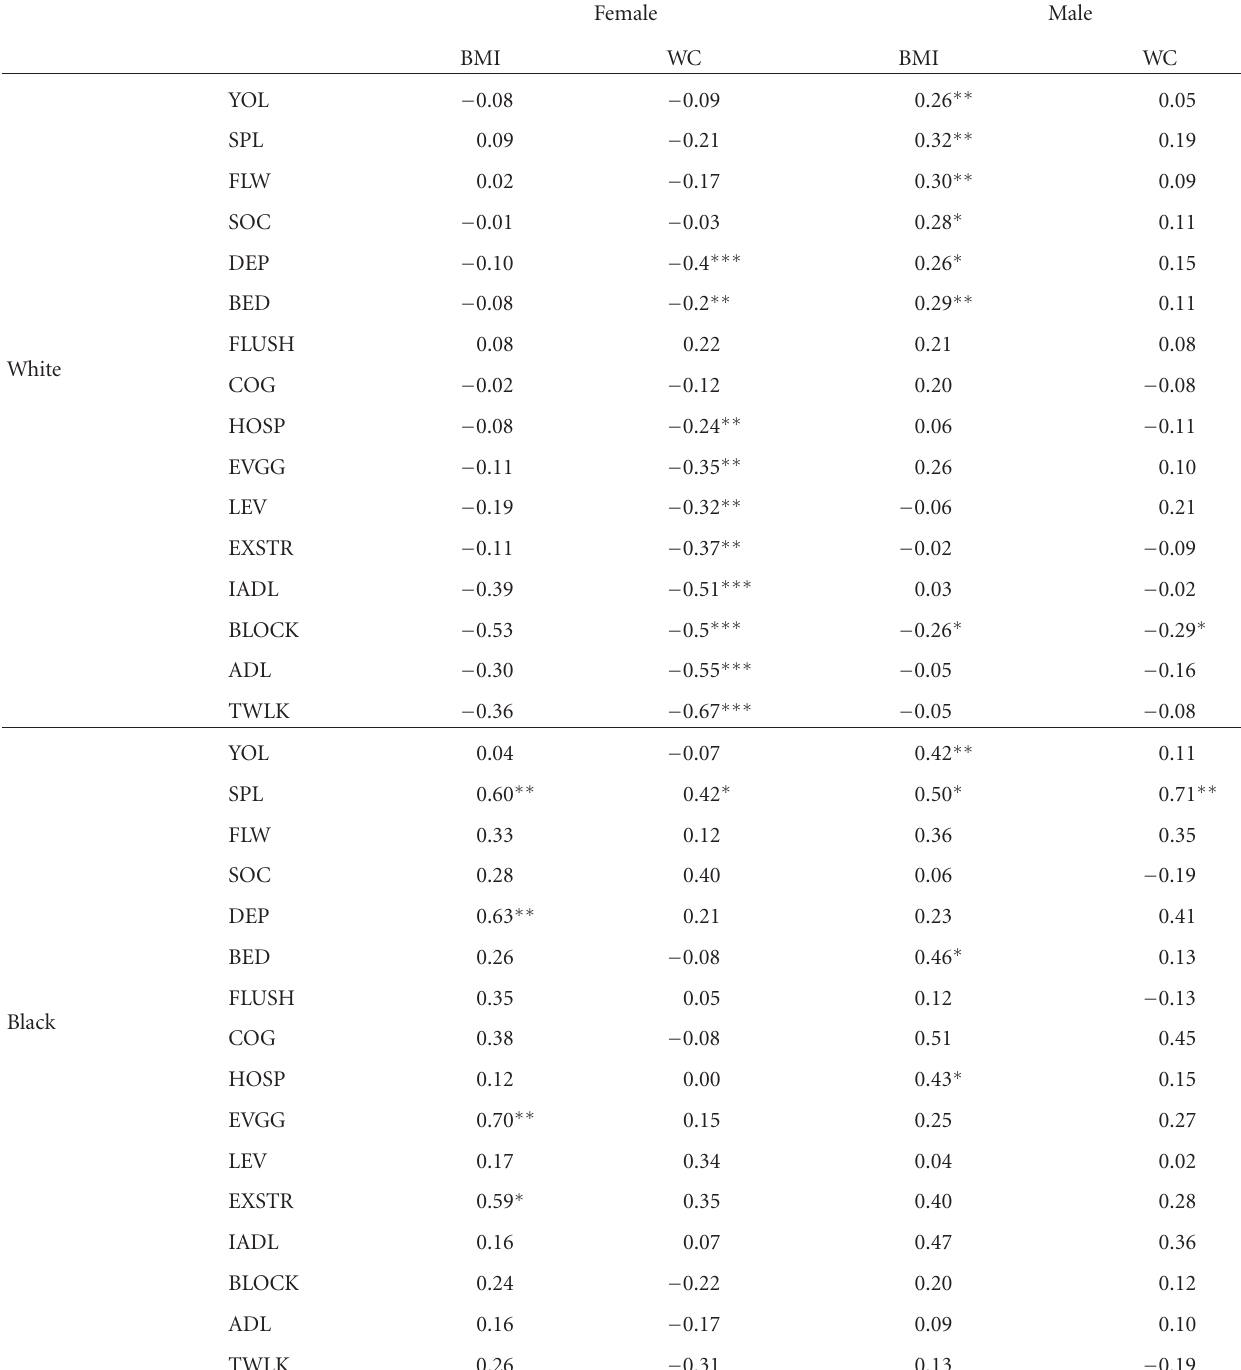
Table 4: Adjusted di ff erence between Overweight and Normal (years) (negative values favor Normal